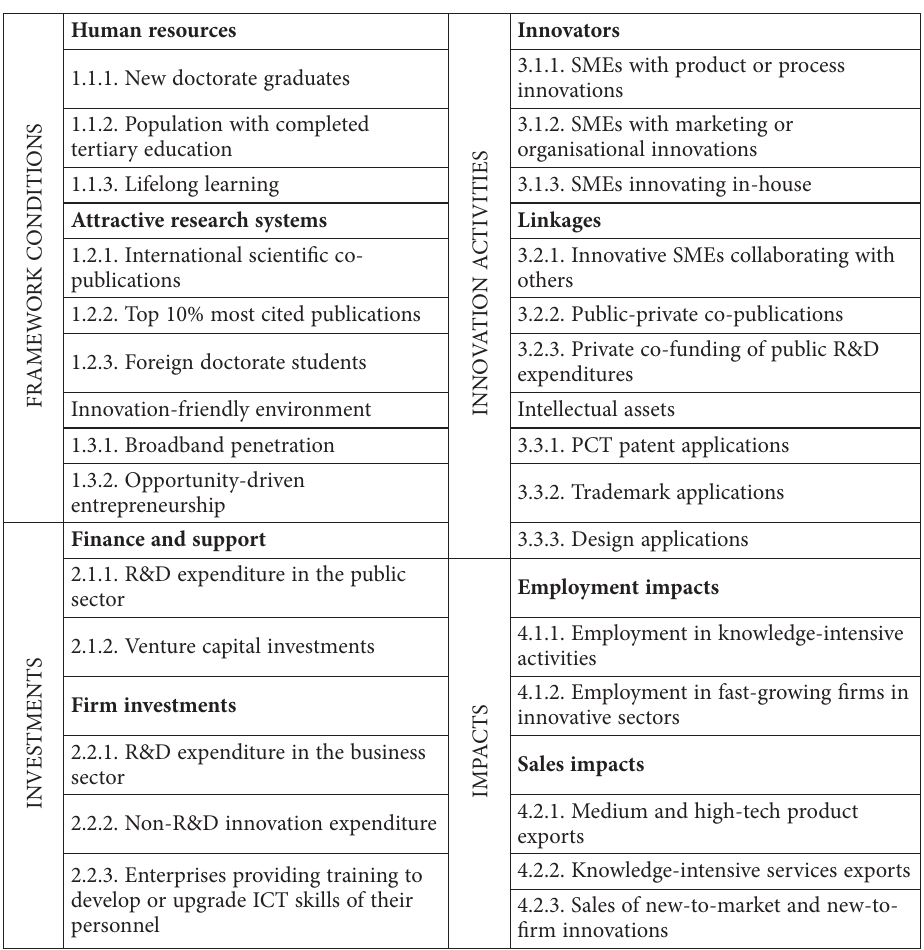
Table 1. The structure of Summary Innovation Index based on European Innovation Scoreboard 2018 (source: own elaboration based on European Commission, 2018. European Innovation Scoreboard 2018)